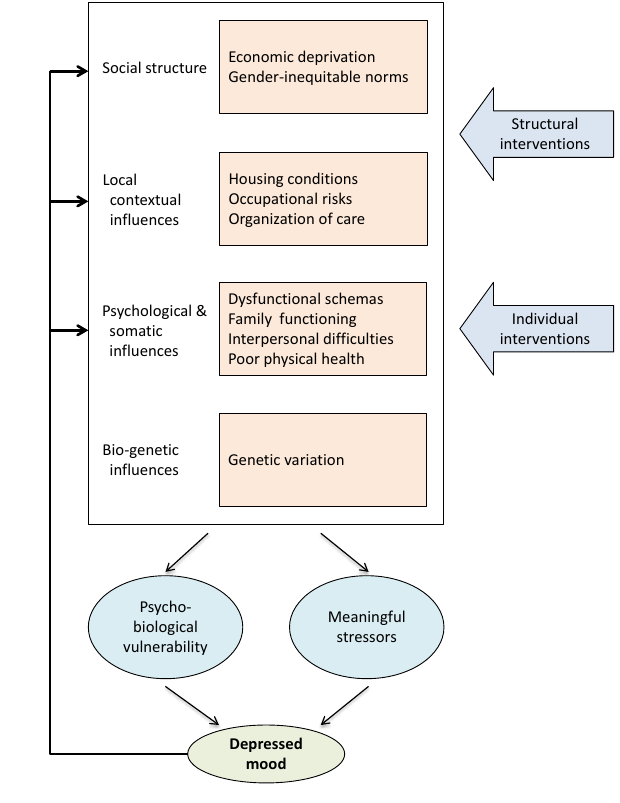
Figure 1 Conceptual framework of multilevel influences on depression and corresponding types of interventions. Adapted from McKinlay & Marceau